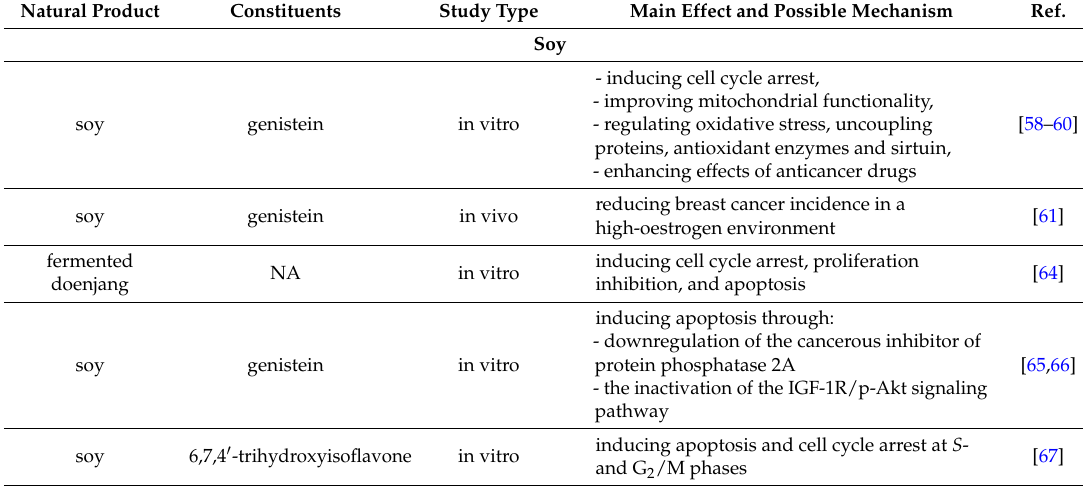
Table 2. The in vitro and in vivo effects of dietary natural products against breast